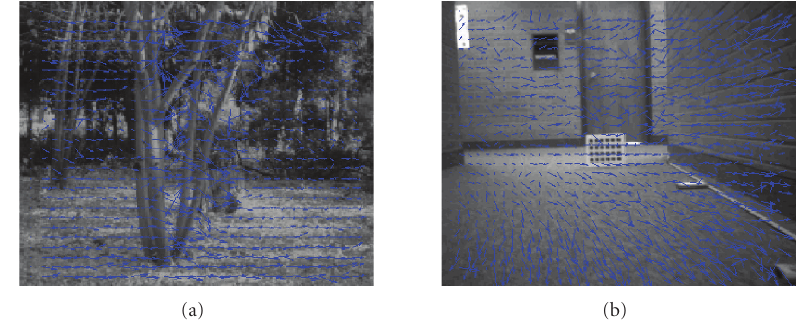
Figure 7: Result of real sequences: (a) SRI trees and (b) corridor.